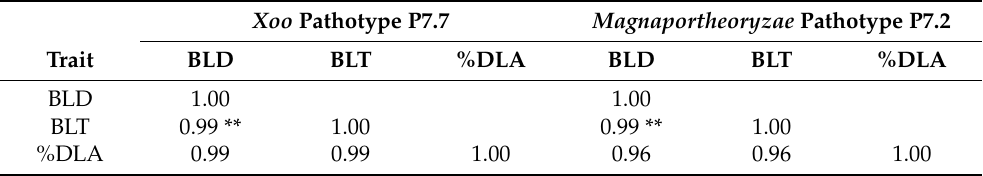
Table 6. Correlation coefficients among lesion degree (BLD), lesion type (BLT) and percentage disease leaf area (%DLA) for pathotypes. P7.7 and P7.2 in parental and improved populations. Xoo Pathotype P7.7 Magnaportheoryzae Pathotype